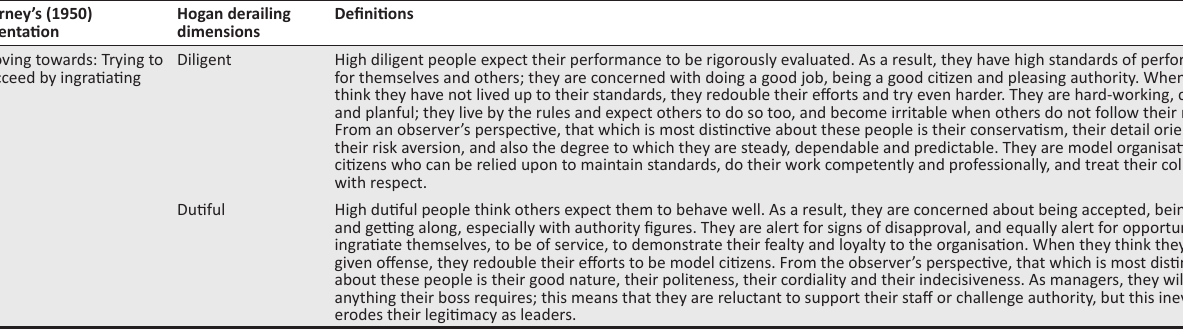
TABLE 2 (Continues...): The Hogan typology of